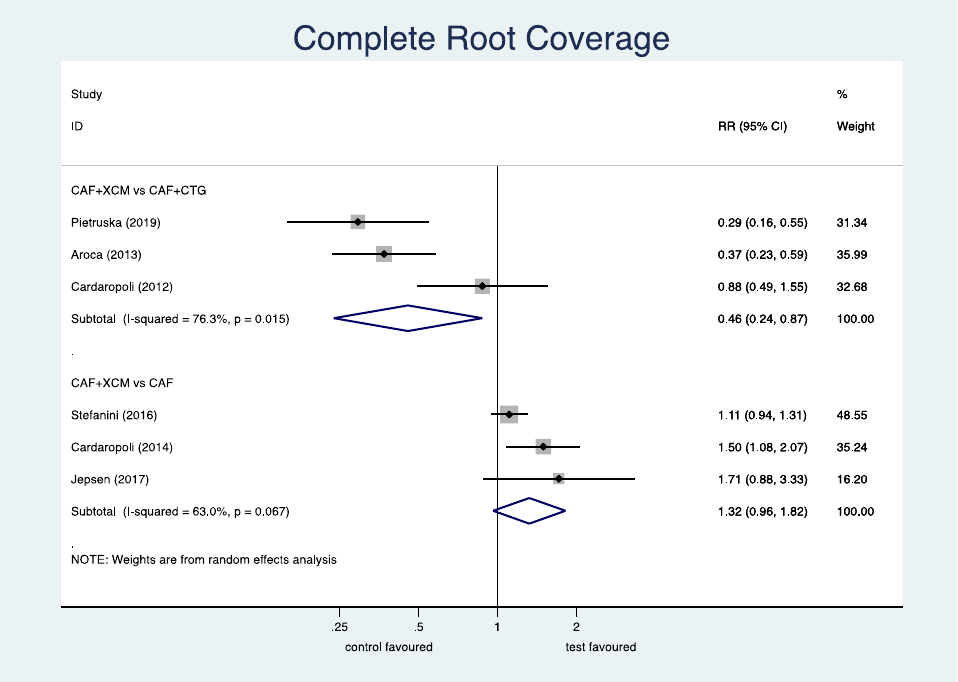
Figure 4. Forest plot relating to complete root coverage.